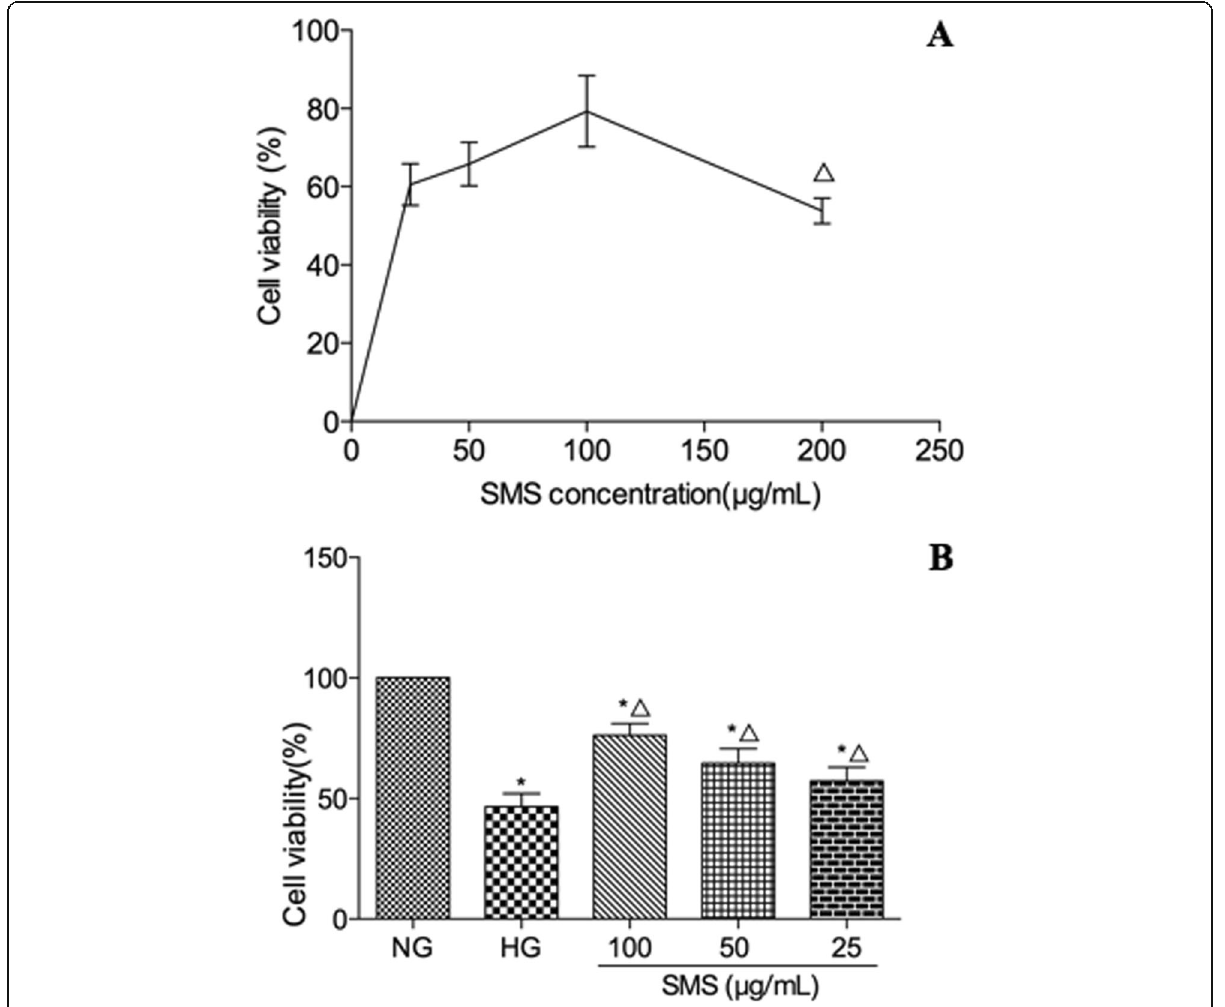
Fig. 2 Effects of SMS on the H9C2 cell viability. a H9C2 cells were treated with different concentrations of SMS under normal glucose environment for 24 h. ( △ p < 0.05 vs. control cells). b SMS increases H9C2 cell viability exposed to HG ( n = 3 in each group). (* p < 0.05: vs. NG group; △ p < 0.05: vs. HG